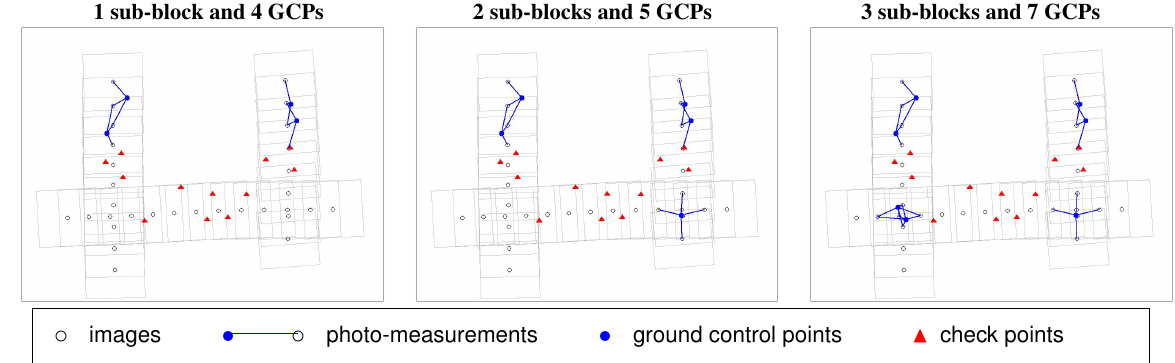
Figure 1: Pavia corridor: sub-block and GCP configurations.